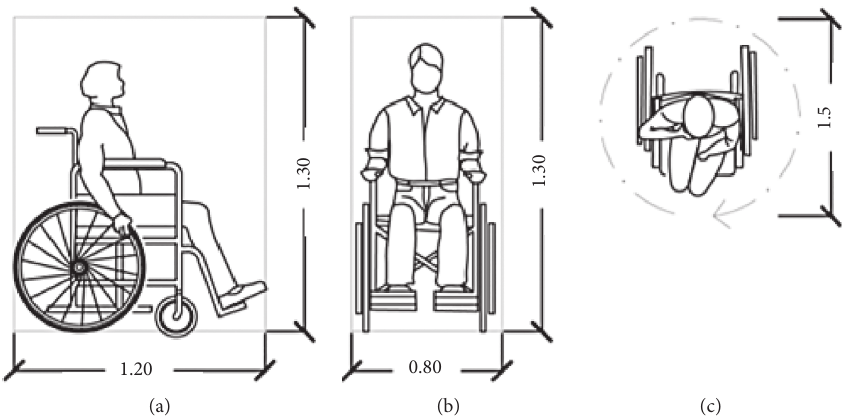
Figure 2: Dimensions (in m) of a wheelchair user in Chile reported by SERVIU